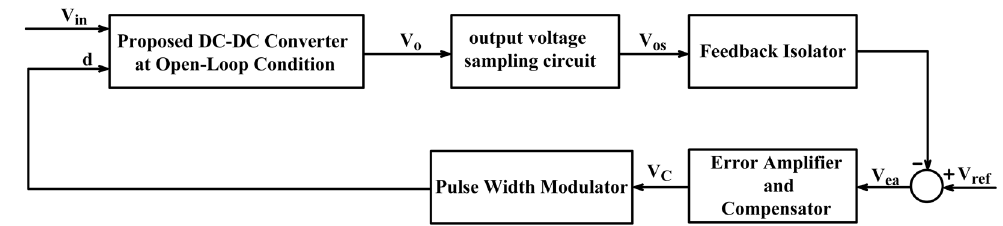
Figure 5. The block control of the proposed high step-up three-level converter.